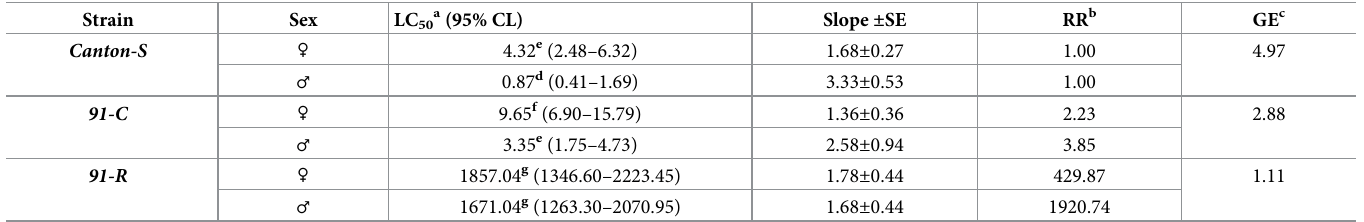
Table 1. LC 50 ( μ g/vial DDT) values with 95% confidence limits (CL), slope, resistance ratio (RR), and gender effect (GE) for D . melanogaster Canton-S , 91-C , and 91-R adult females and males fed on diet without